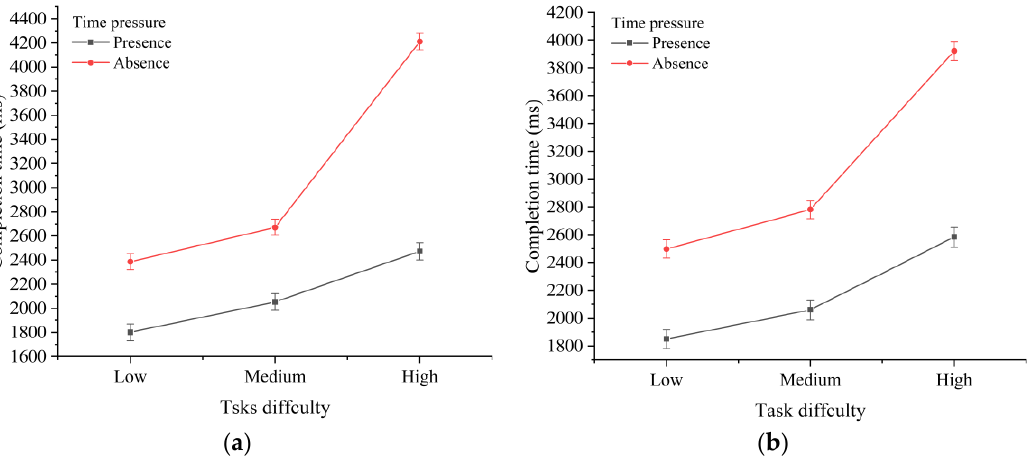
Figure 3. Effects of task difficulty and time pressure on the response time under ( a ) touchscreen and ( b ) normal screen conditions.